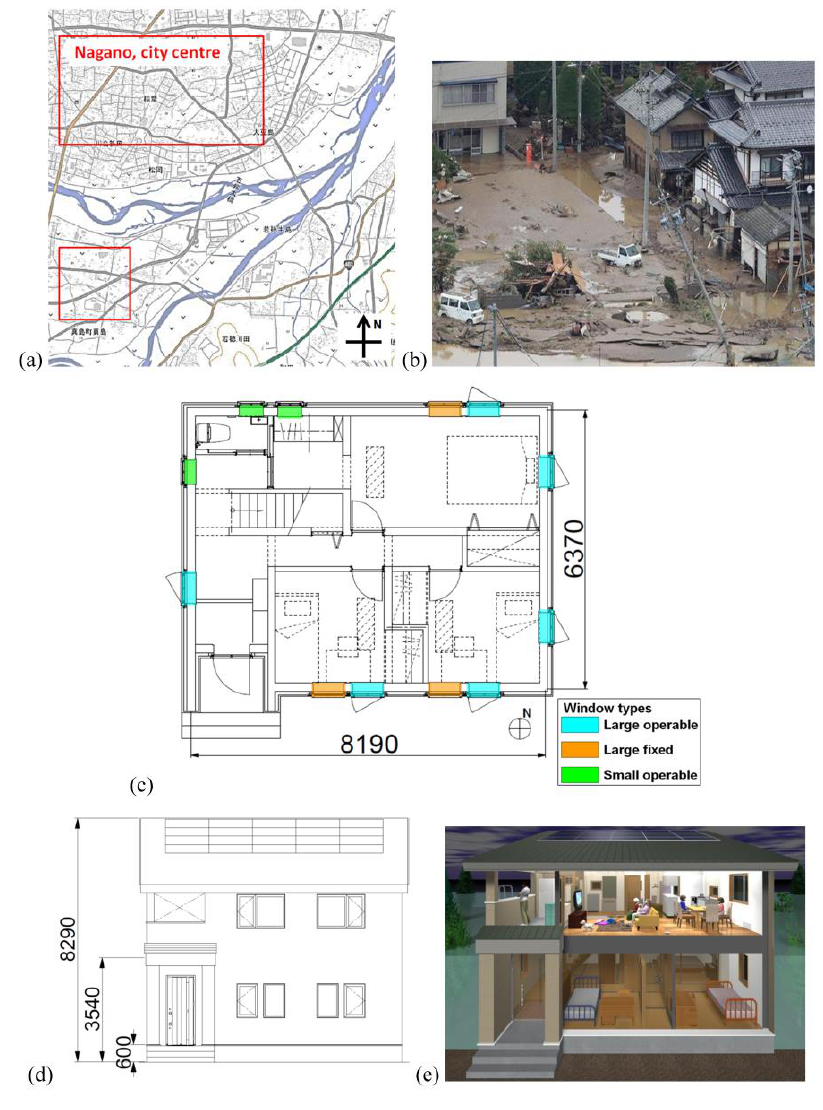
Figure 1. Development of the prototype residential building ( a ) overview of the considered area [48], ( b ) partial submersion of residential buildings during the flood of 2019 [49], ( c ) ground floor plan of the prototype building (unit: mm) ( d ) south elevation and ( e ) perspective building during a flood.